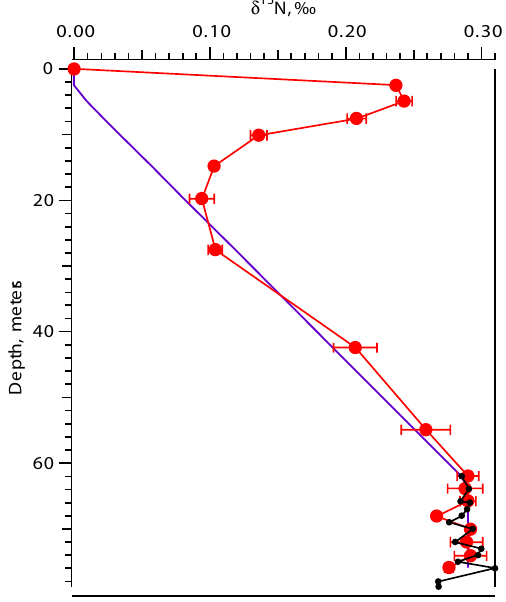
Fig. A1. Present-day firn at NEEM. Red dots: δ 15 N data measured at LSCE. Blue line: gravitational fractionation for δ 15 N, assum- ing a convective zone of 3m and the LID at 63m depth (Buizert et al., 2012). Black dots: modeled δ 15 N with the Goujon firnifica- tion